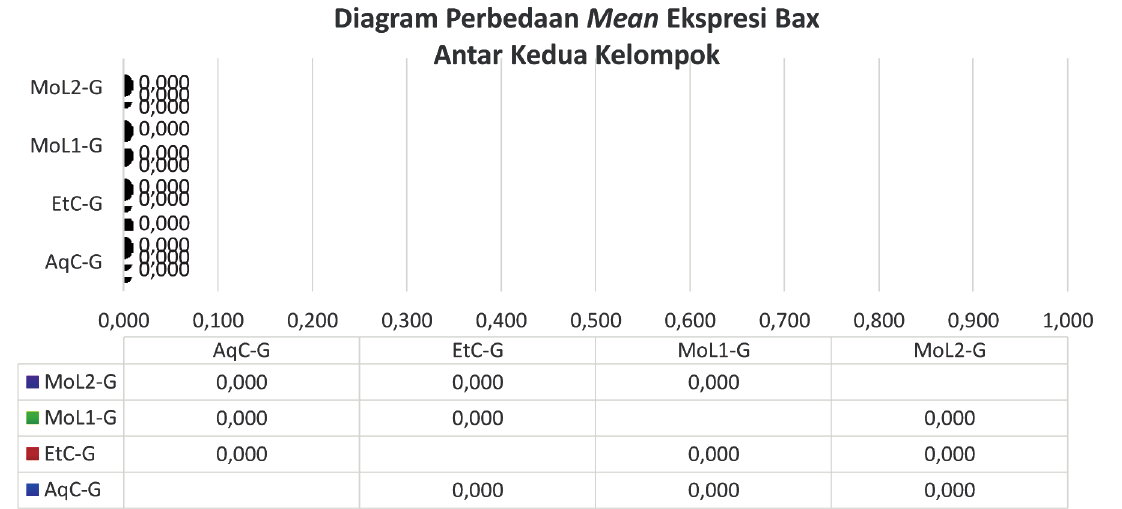
Figure 4. Mean Differences of Bax expressions between two